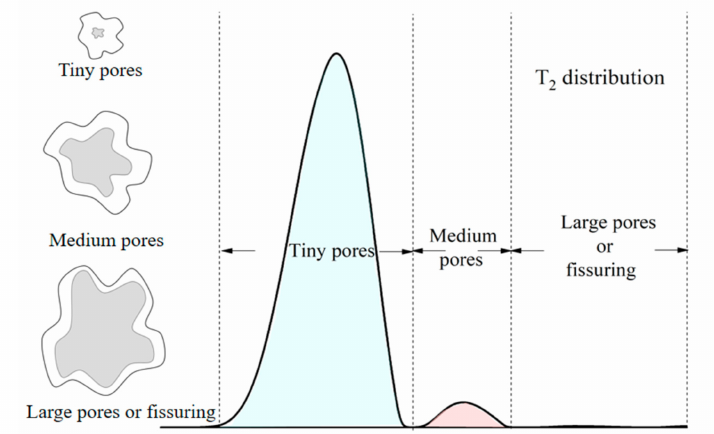
Figure 7. Pore size distribution (PSD) spectrum corresponding to pore size. The small pores represent the main peak area, the subpeak is the medium pores, and the large pores are in the tail of the curve.